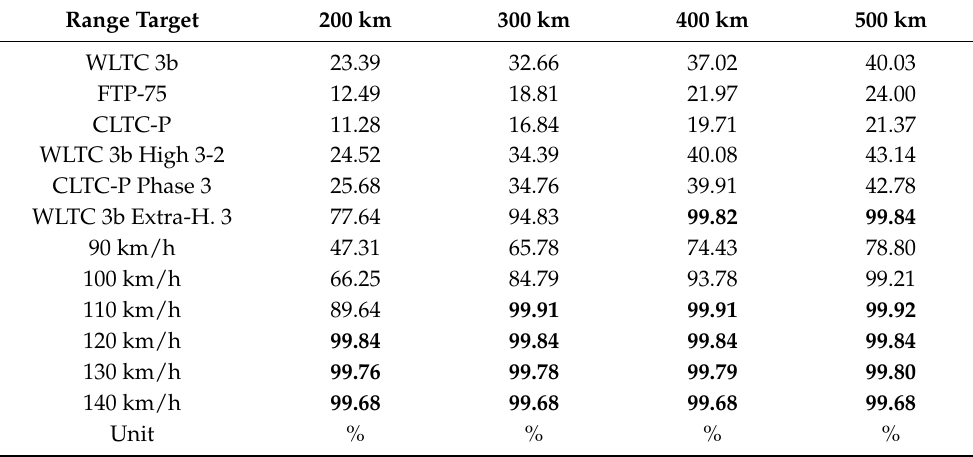
Table A6. REX utilization measures % of total driving time when REX is enabled. Bolded values indicate that REX is engaged once and working constantly, and a range target cannot be obtained. Vehicle mass equals to 2100